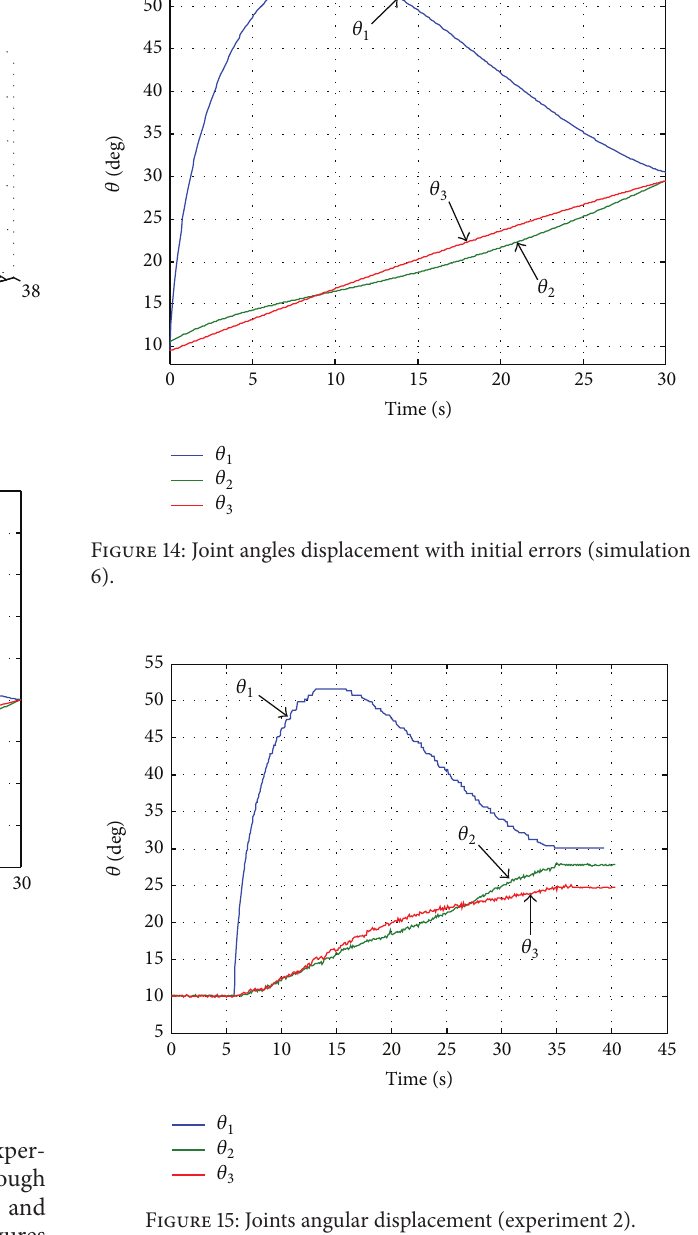
Figure 15: Joints angular displacement (experiment